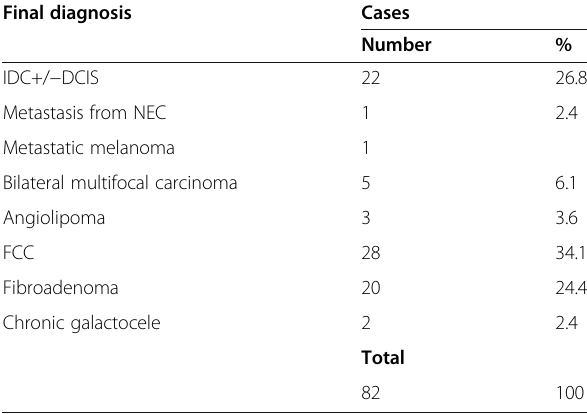
Table 1 Final pathological diagnosis of cases included in this